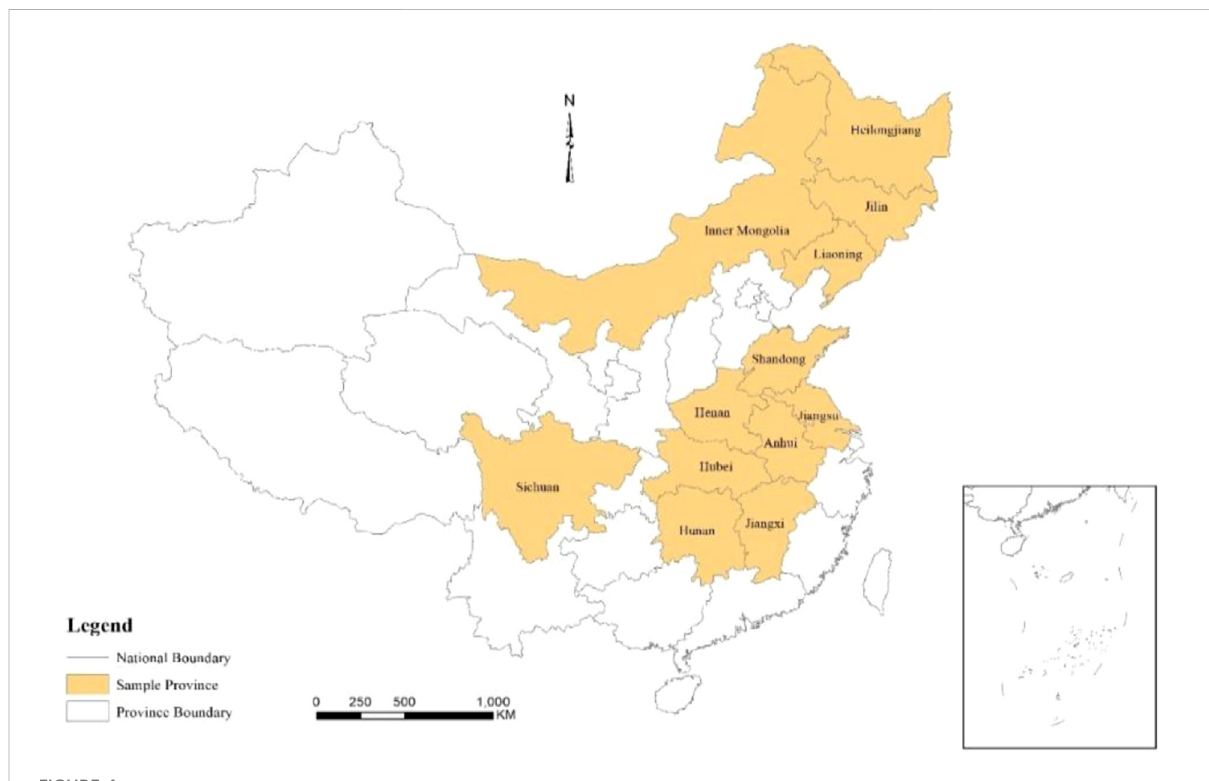
FIGURE 4 Location of major grain-producing provinces in